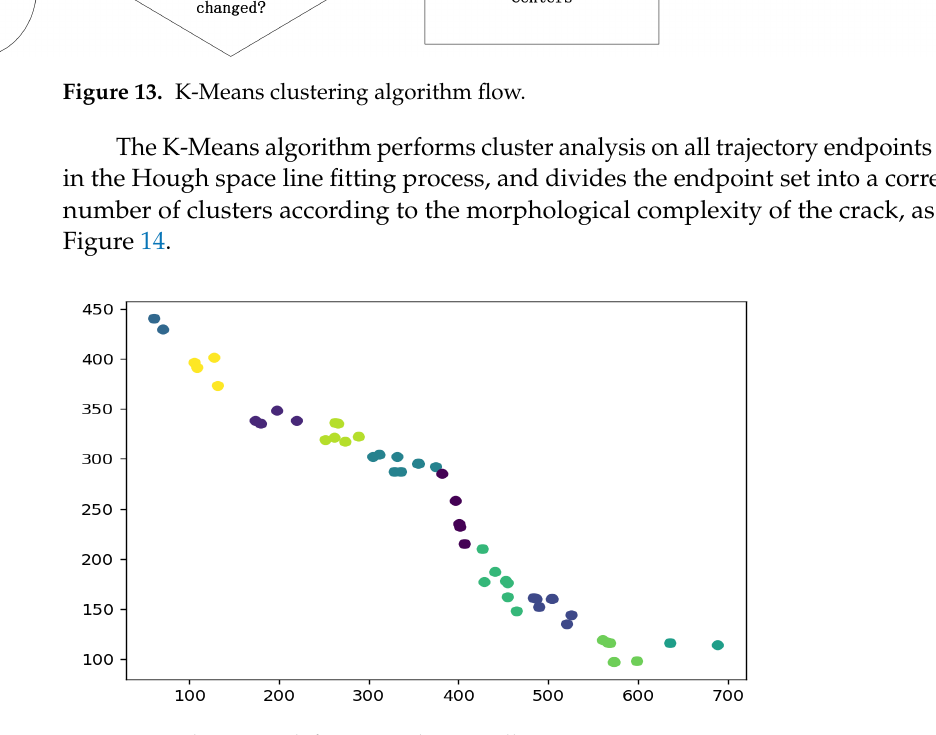
Figure 14. Cluster crack feature endpoint collection.